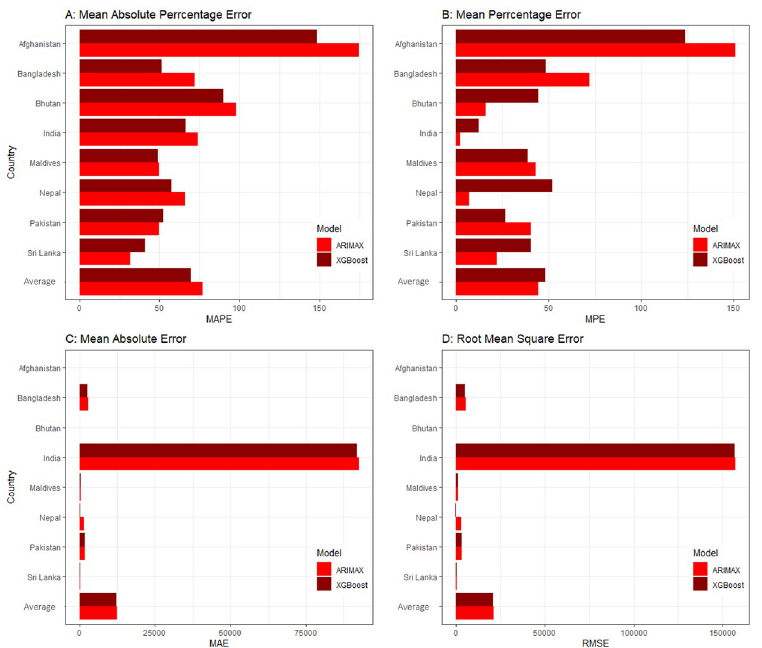
Fig 5. Performance metrics of the ARIMAX and XGBoost models for predicting COVID-19 confirmed cases in SAARC countries.